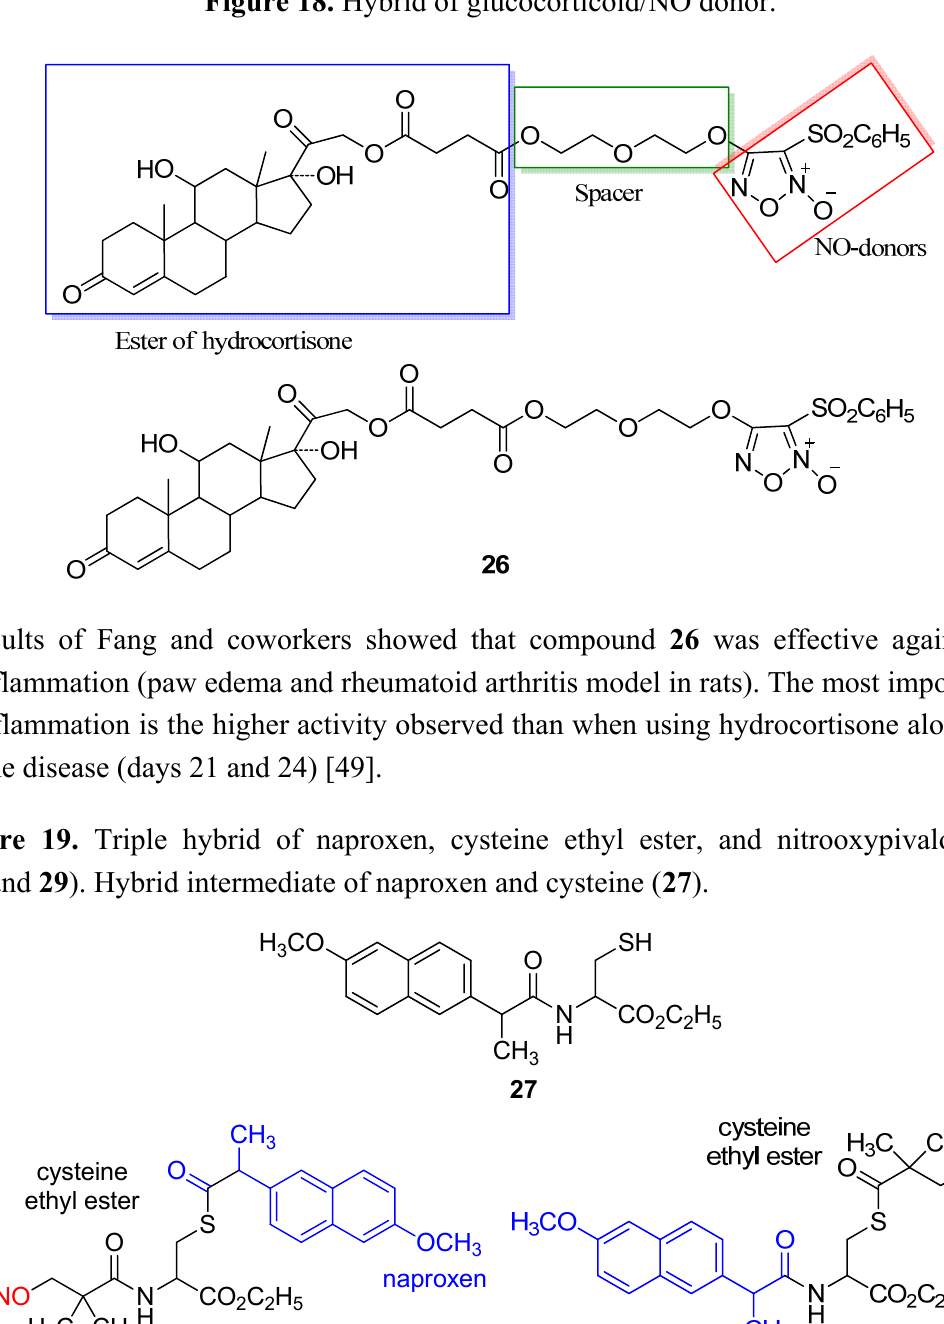
Figure 18. Hybrid of glucocorticoid/NO donor.